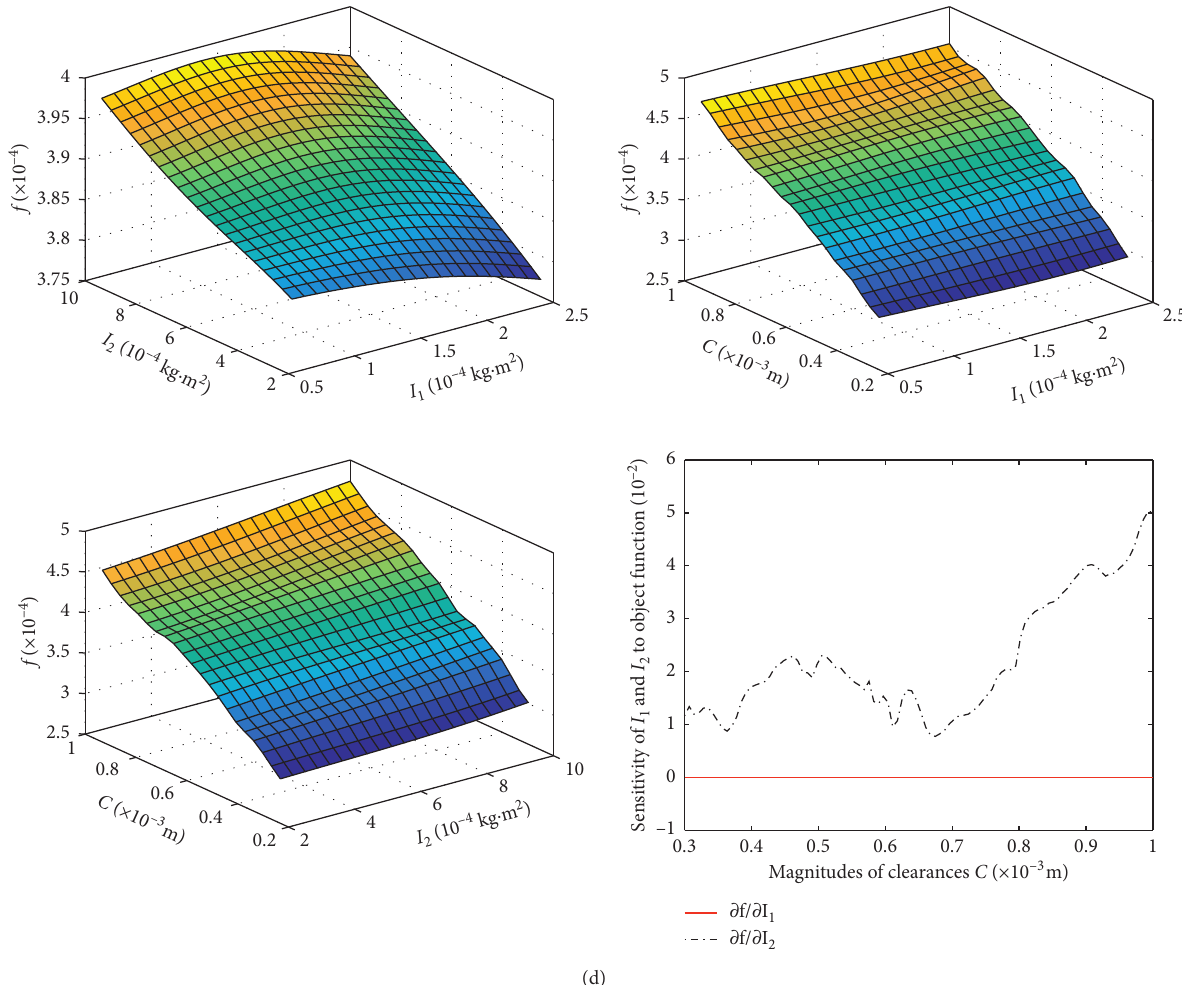
Figure 5: (a) Surface plots between objective function f and design variables m function f at different magnitudes of clearance C . (b) Surface plots between objective function f and design variables m with sensitivity of m and m to object function f at different magnitudes of clearance C . (c) Surface plots between objective function f and 2 3 , u , and C , along with sensitivity of u design variables u 1 2 between objective function f and design variables I magnitudes of clearance C